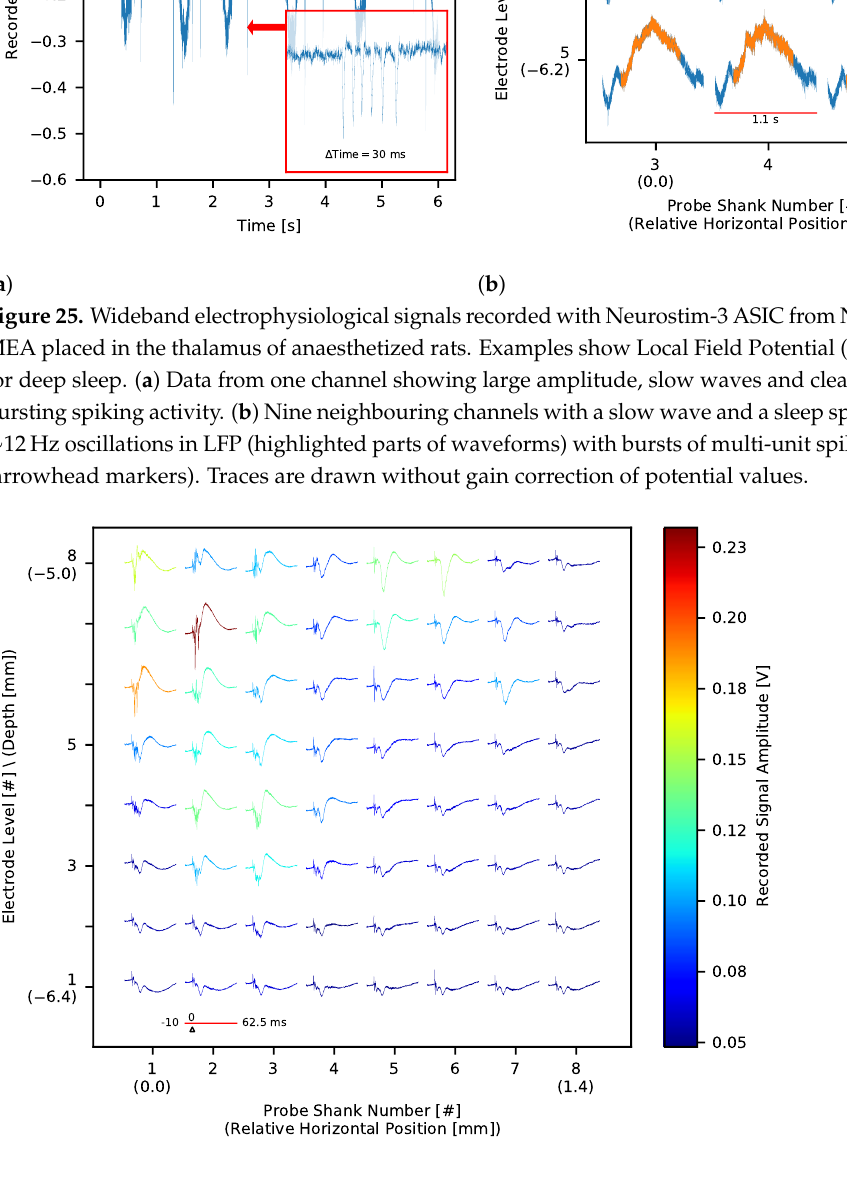
Figure 26. Average ( n = 100) evoked potential responses to whisker stimulation calculated for all MEA sites placed in a rat somatosensory thalamus. The largest amplitude and shortest latency of responses indicate that the electrodes in the top-left corner of the drawing were located in the region of the representation of large whiskers. In other channels, we record volume conducted signals of diminishing amplitude. Each average response is 62.5ms long with 10ms pre-trigger LFP and its amplitude is colour-coded (note that gain correction was not